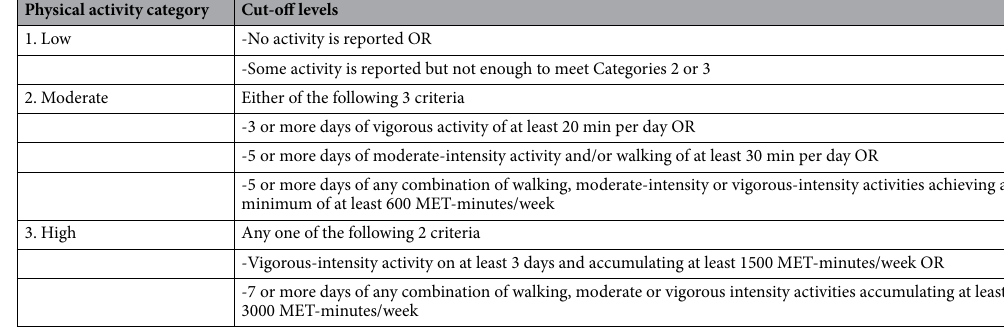
Table 1. Three physical activity categories based on IPAQ. Adapted from the guidelines for data processing and analysis of the international physical activity questionnaire (IPAQ)- short and long forms (November